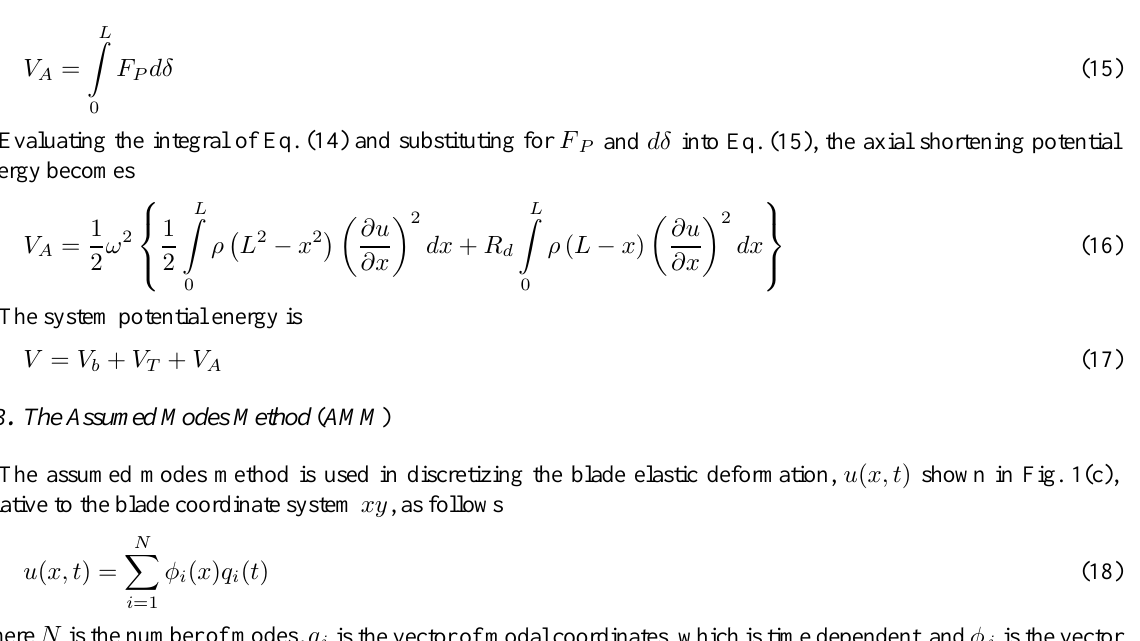
Fig. 5. Natural Frequencies as function of shaft torsional stiffness R D for rotating speeds: ω = 0, 50, 100, 150